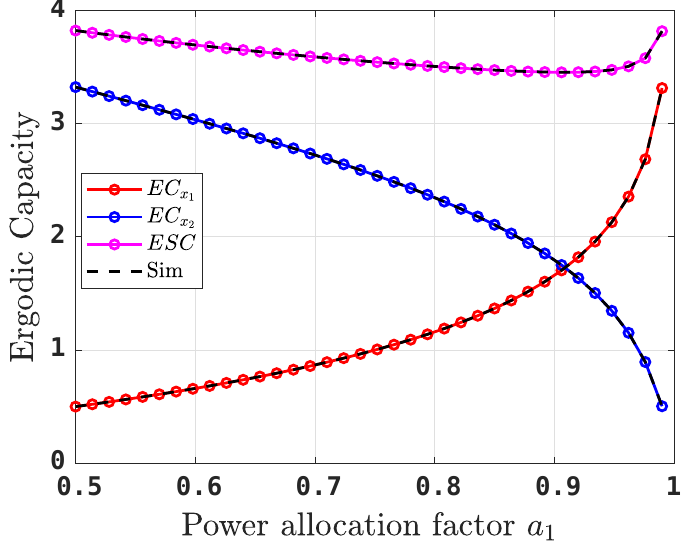
Figure 10. ECs over the entire range of power allocation factor at ρ = 50